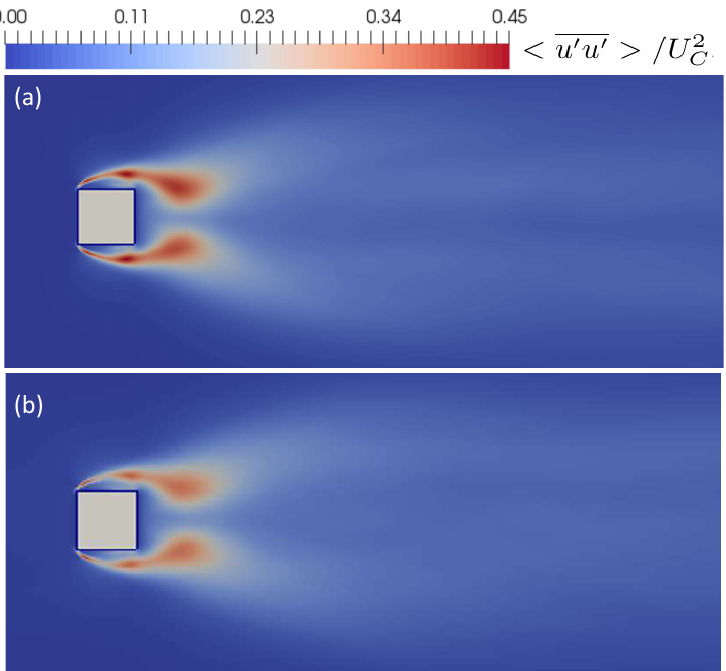
Figure 8. Time and spanwise-averaged Reynolds normal stress < u (cid:48) u (cid:48) > / U 2 ( b ) ILS = 0.2D, TI = 0.10.